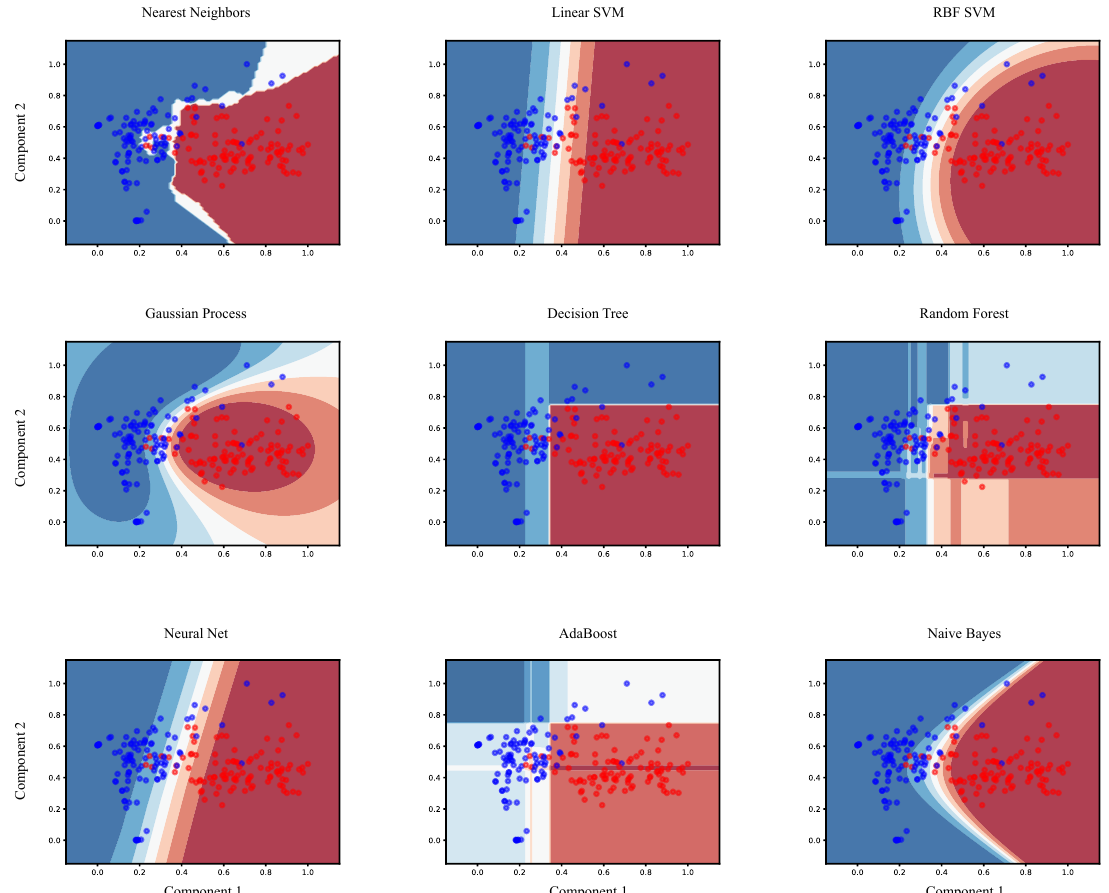
Figure 9. Differen apple fruit pixels classifiers development